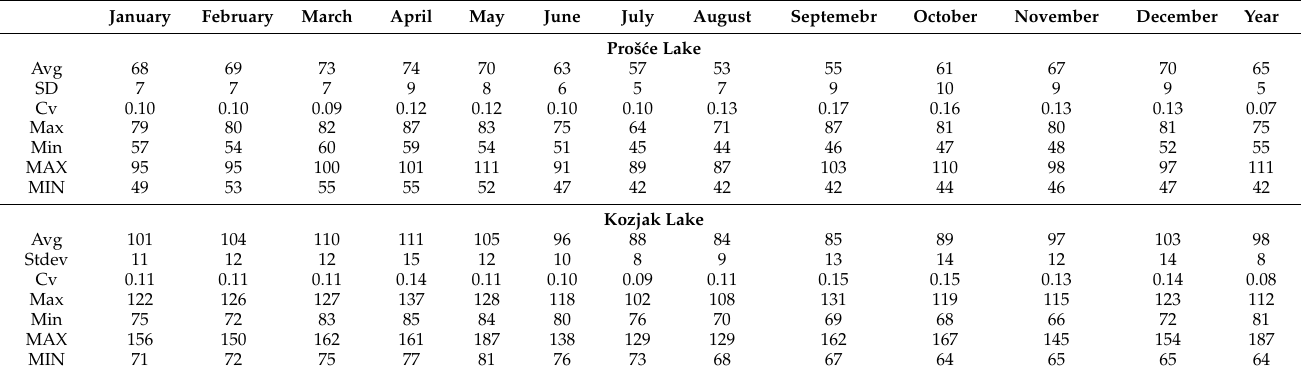
Table 2. Mean monthly and annual water levels (cm) at the Proš´ce and Kozjak Lake stations (2001–2020) (Note: Avg— average; SD—standard deviation; Cv—coefficient of variation; Max—maximum; Min—minimum; MAX—absolute maxi- mum; MIN—absolute